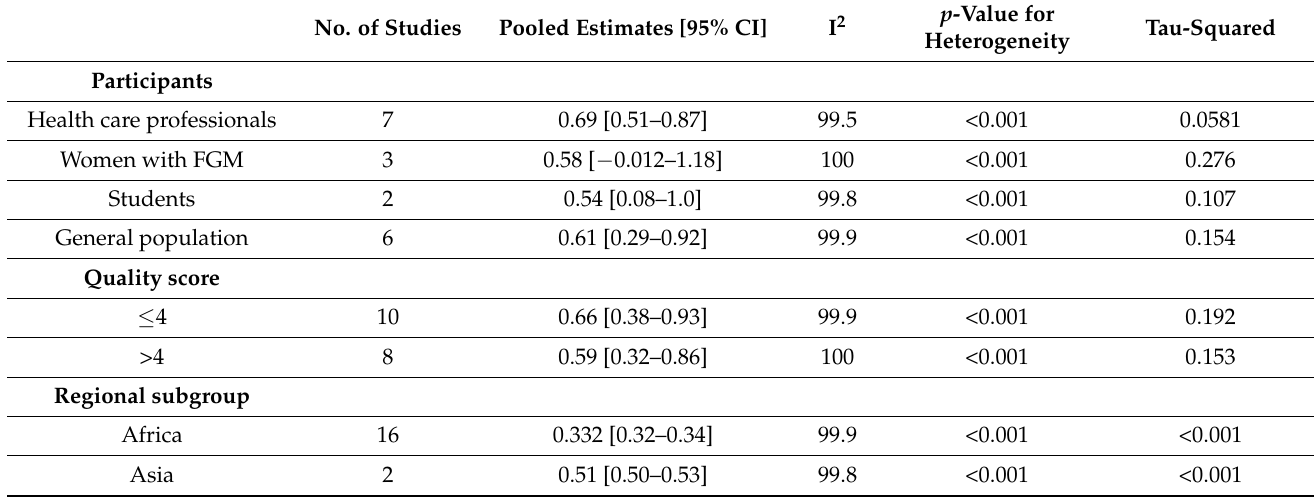
Table 3. Findings of the subgroup analyses of attitudes toward circumcising daughters now or in the